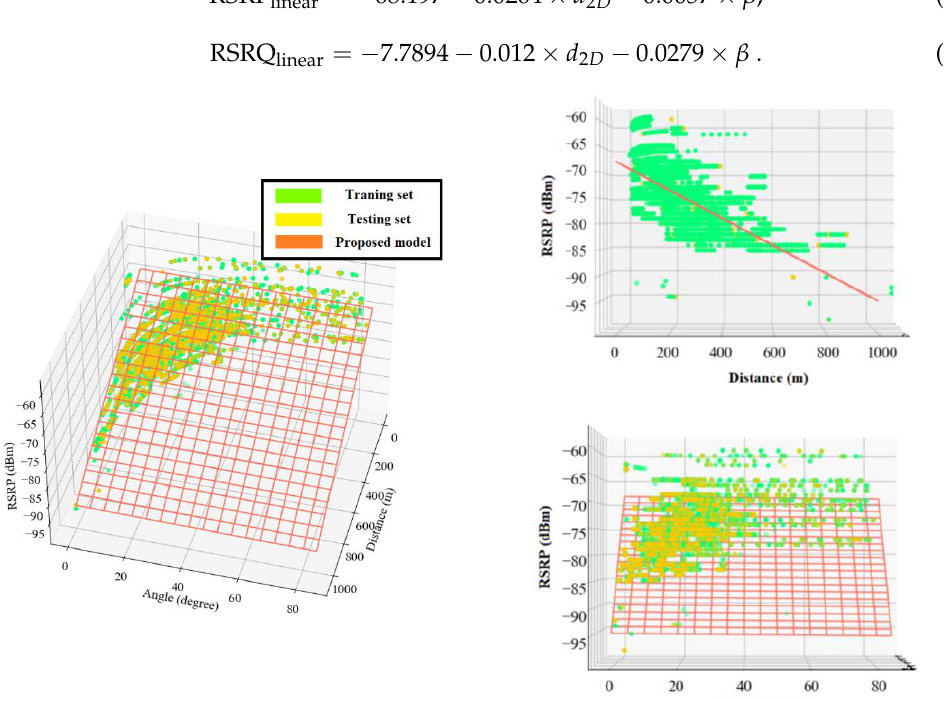
Figure 11. 3D representation of the proposed linear regression model for RSRP.